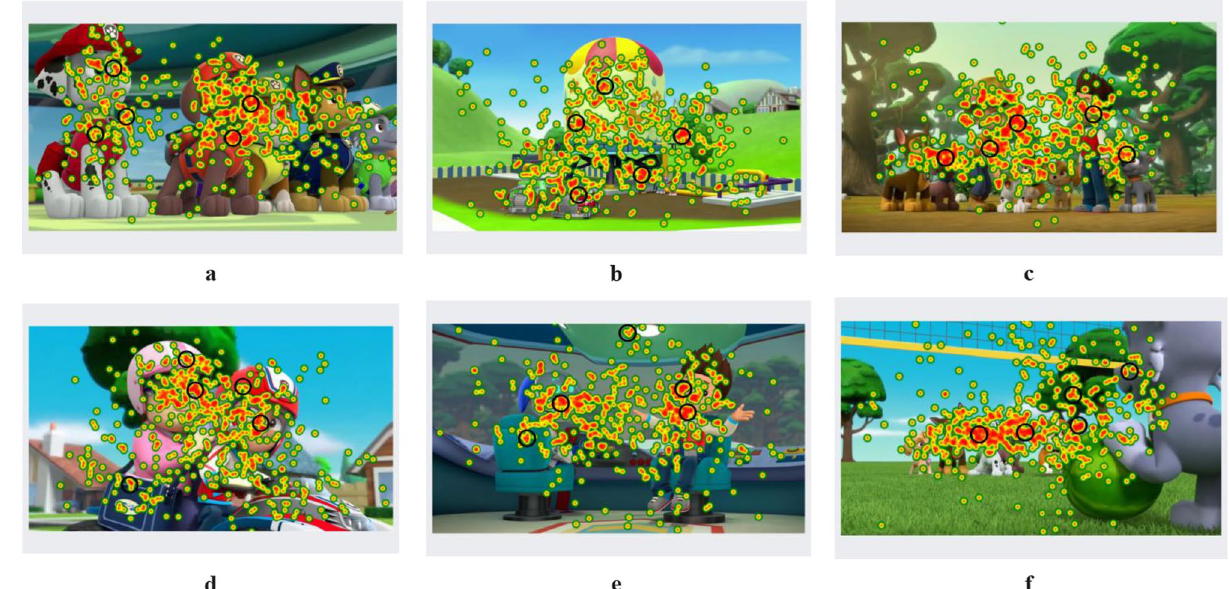
Figure 1. Animated image eye-tracking hot zone